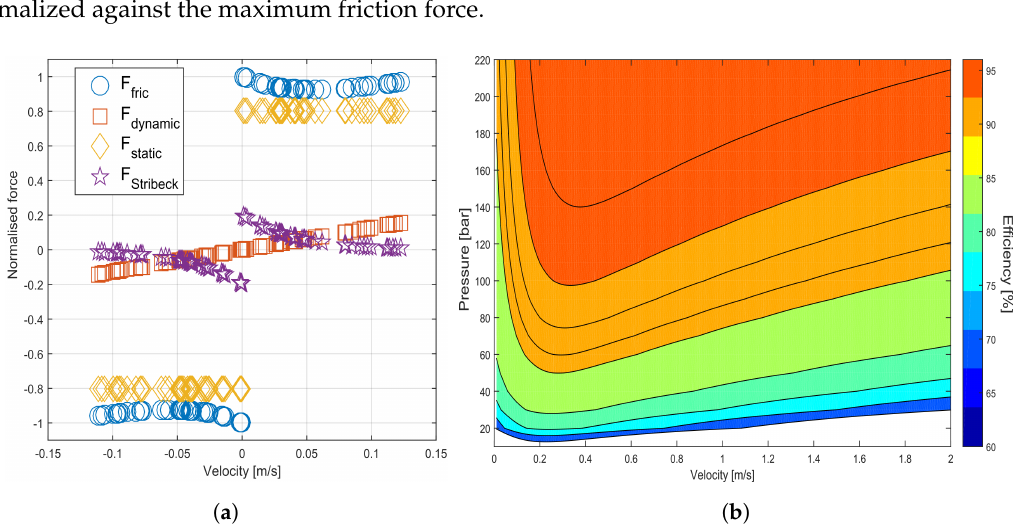
Figure 4. Friction losses in the hydraulic cylinder: ( a ) the impact of different friction effects normalised against the maximum friction force; and ( b ) the approximated efficiency map of a cylinder, reproduced from